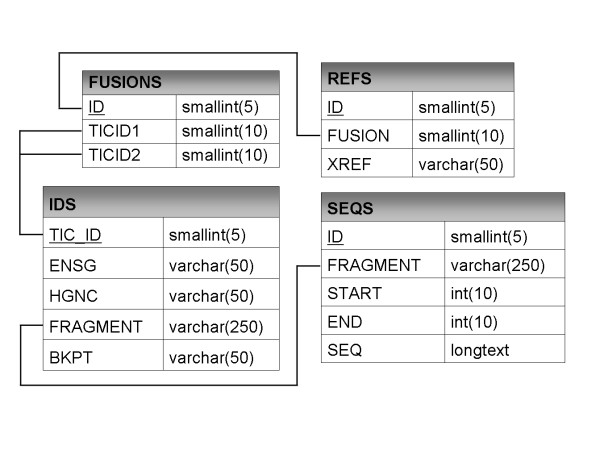
Schema of TICdb, showing the field-names and field-types for each table; underlined field names indicate primary keys.